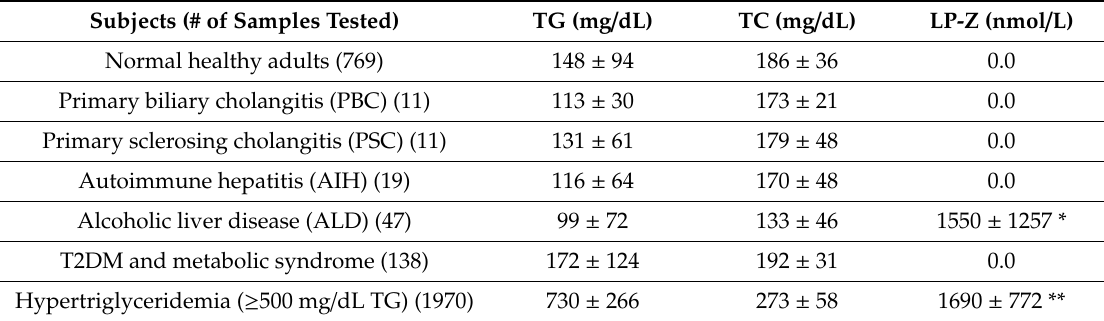
Table 3. Plasma / serum levels of LP-Z particles, along with triglyceride (TG) and total cholesterol (TC) levels in normal healthy adults versus subjects with various liver and metabolic